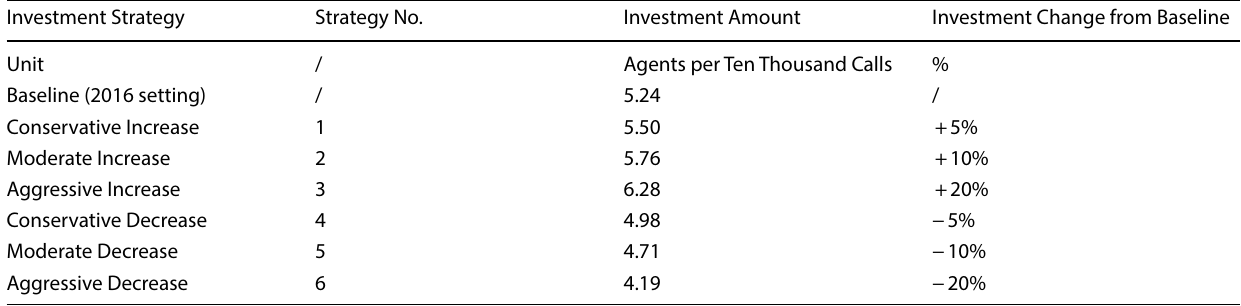
Table 2 Resource planning strategies that are evaluated for Chicago 311 contact center Investment Strategy Strategy No.